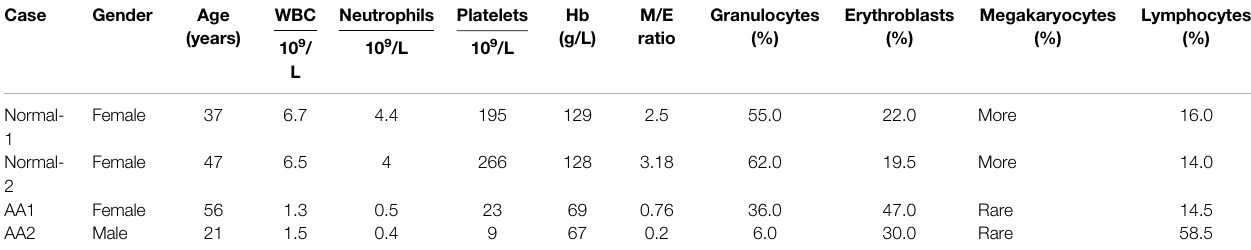
TABLE 1 | Peripheral blood counts and bone marrow features in patients with aplastic anemia and healthy donors.